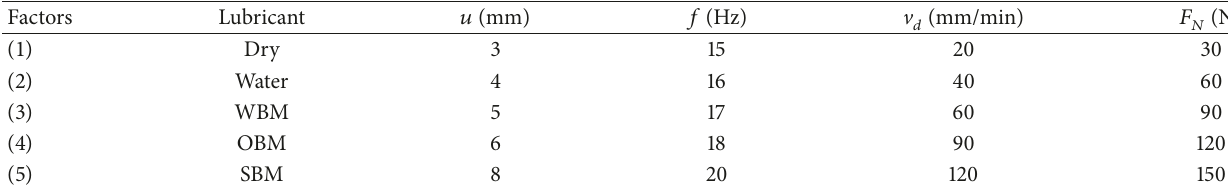
Table 3: Factor level in orthogonal experiment.